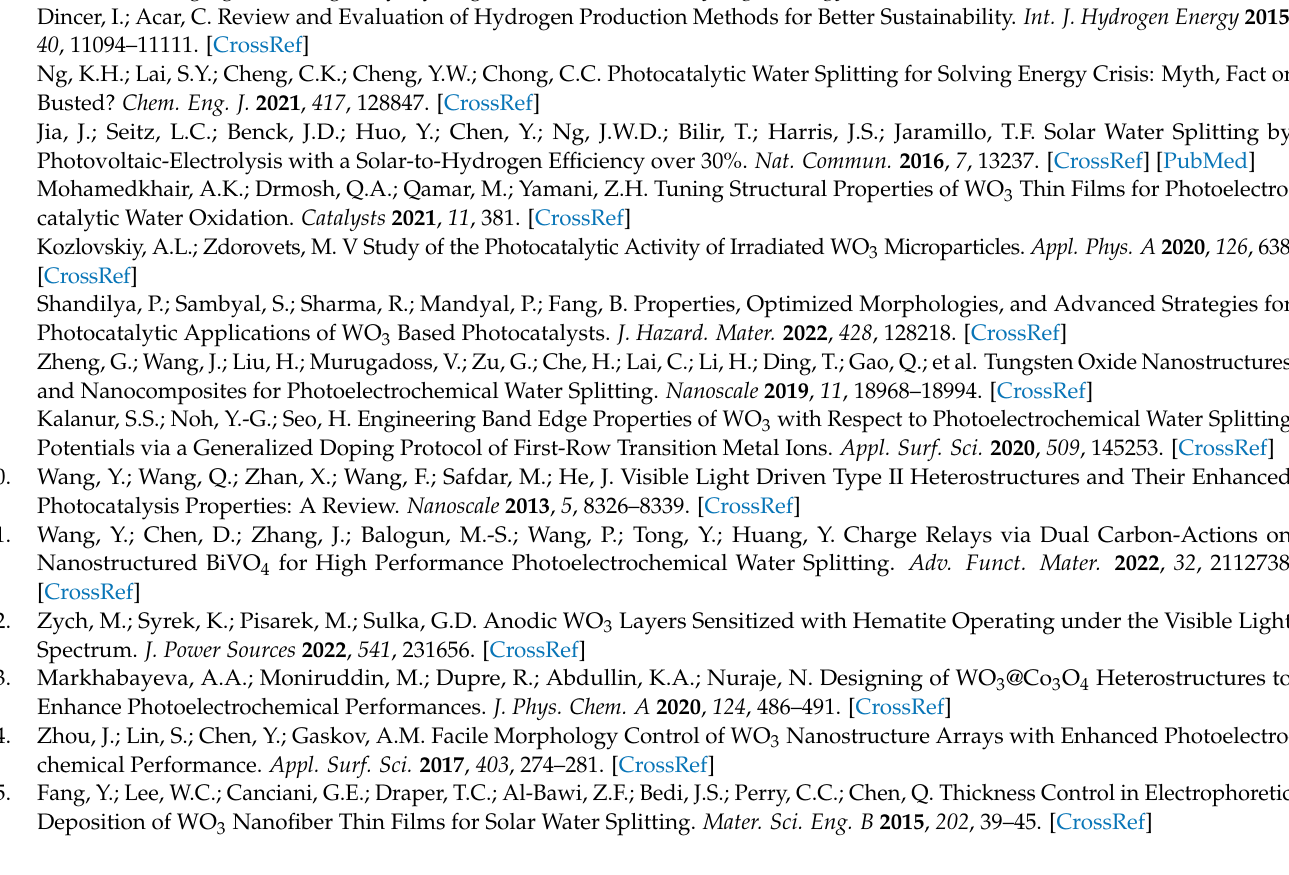
Figure S3: chopped linear sweep voltammetry curves of double-layer WO 3 before and after the modification with IPIB of 6 A/cm 2 ion beam current density; Figure S4: high-resolution GI-XRD patterns of amorphous WO 3 and FTO